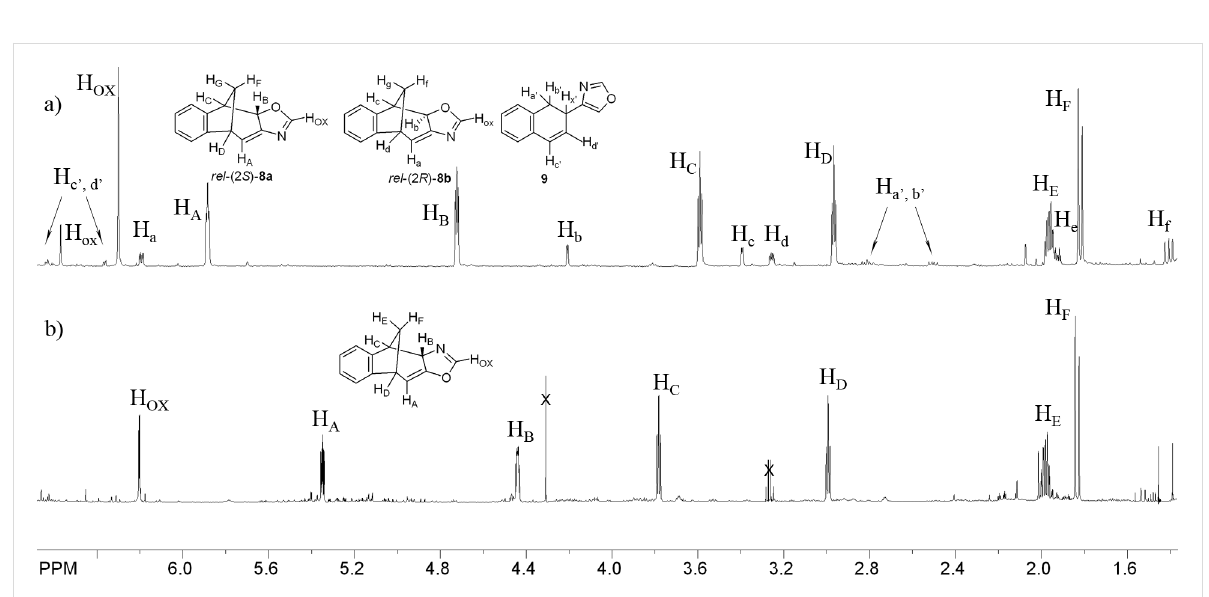
Figure 1: Part of 1 H NMR spectra in C 6 D 6 of the crude photomixtures after 200 min (300 nm, rt ) of irradiation of cis / trans - 1 (a) and cis / trans - 2